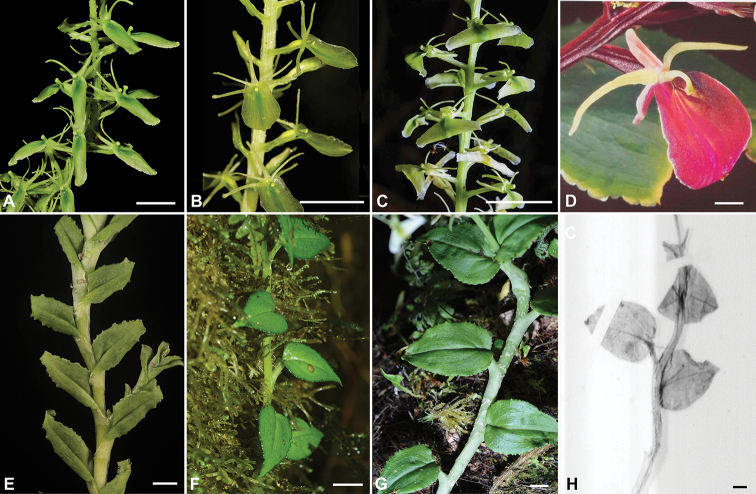
Flowers (A–D) and portions of stem with leaves (E–H) of the species of Liparis
sect.
DecumbentesA, ELiparis
sessilisB, FLiparis
brachystalixC, GLiparis
laticuneataD, HLiparis
crispifolia. Photographs: A L. Rimarachín, B L. Egoavil, C, E, G A. Damián, D A. Hirtz, F G. Salazar. H E. Santiago. Scale bar: 1 cm.